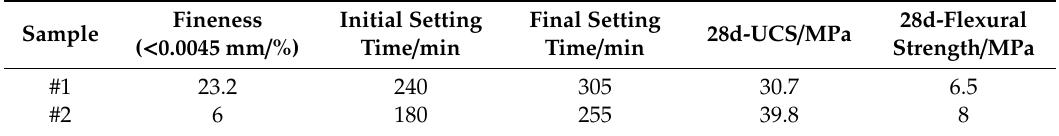
Table 2. Mineralogical composition of fine tailings.